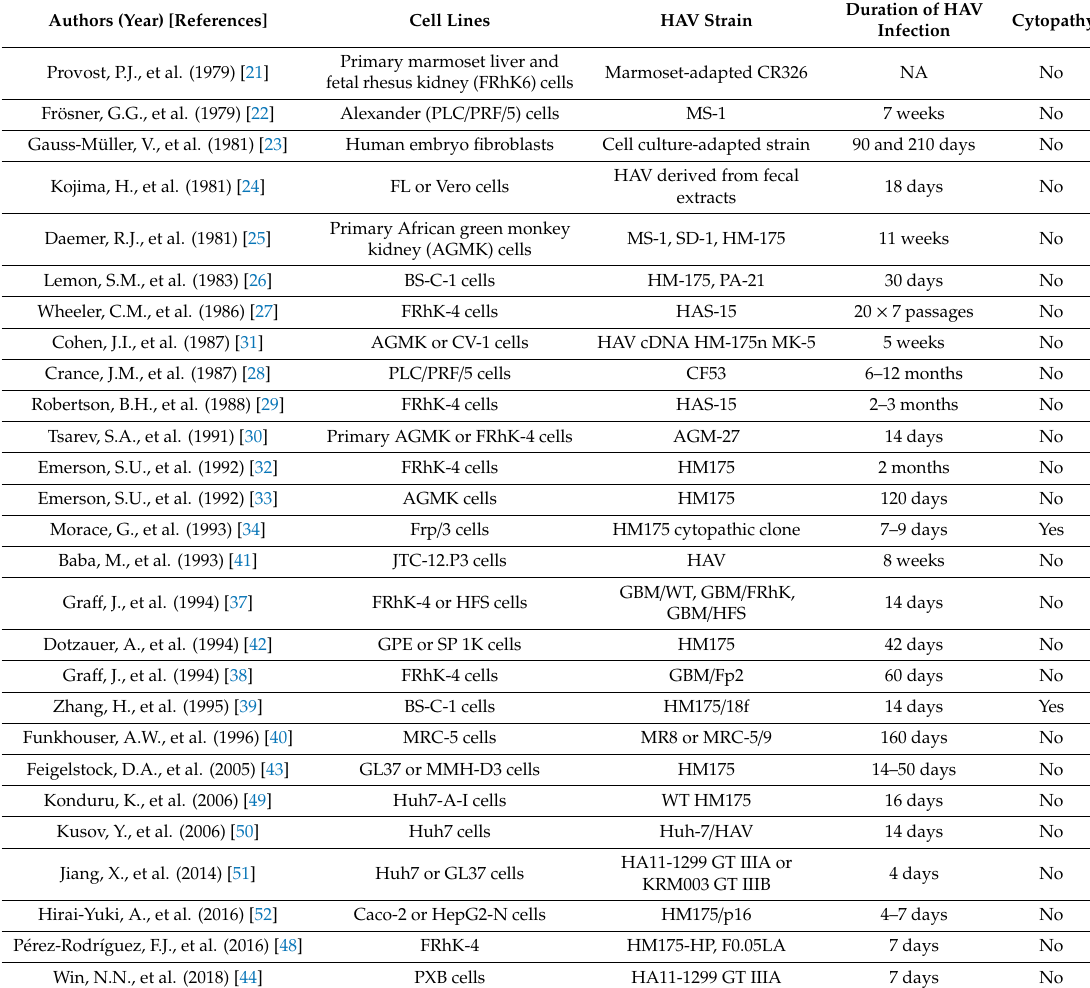
Table 1. Cell lines supporting hepatitis A virus (HAV)